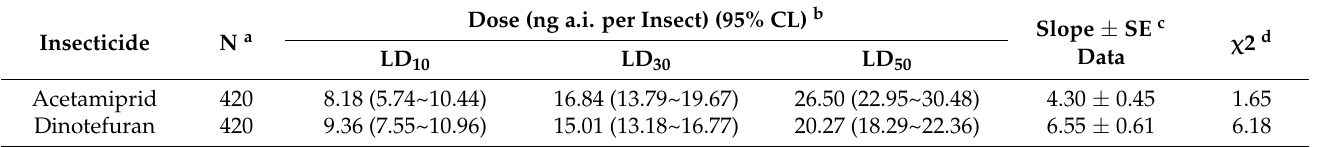
Table 1. Toxicity of acetamiprid and dinotefuran on the second instar larvae of C. pallens .